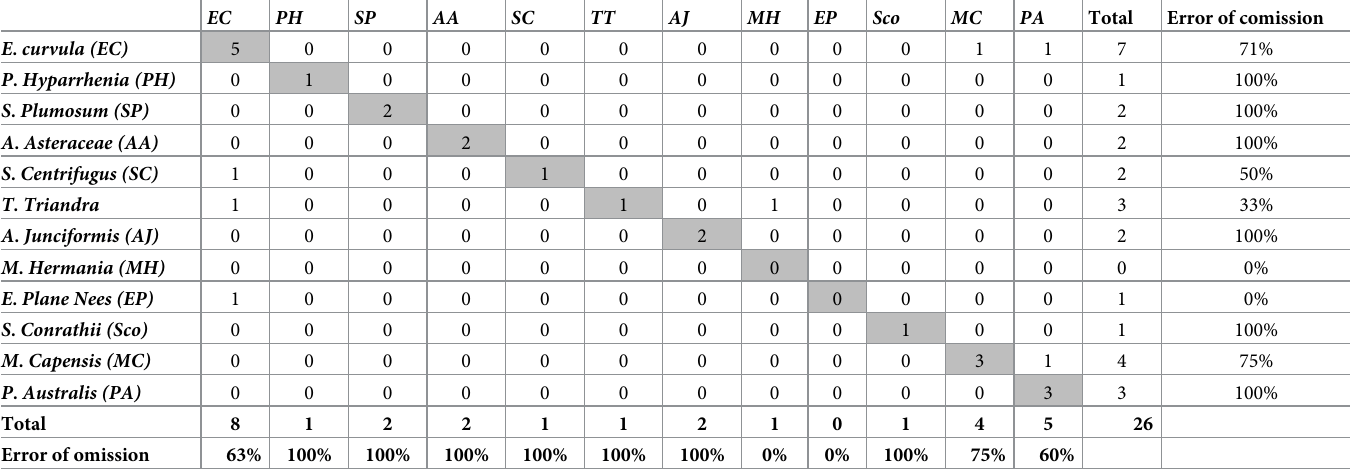
Table 4. Confusion matrix for ASTER MI.